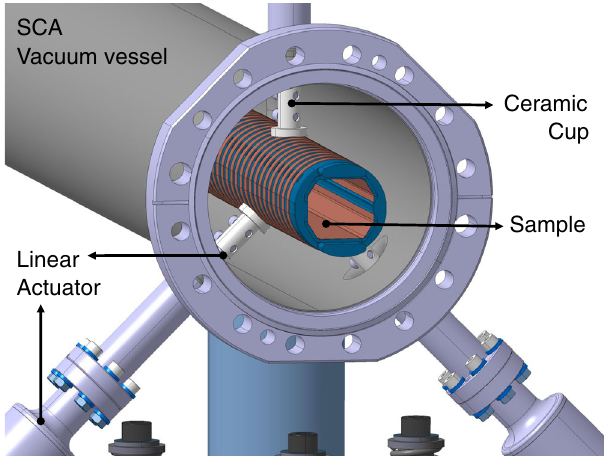
FIG. 3. 3D model of the linear actuators used to hold the samples inside the UHV chamber, installed at one of the extremities of the SCA at the BESTEX.